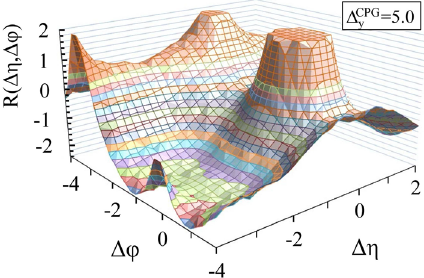
Fig. 7 The R (Δη,Δϕ) distribution simulated with FANSY 2.0 CPG (“strong”) at | Δη | ≤ 4 for high-multiplicity